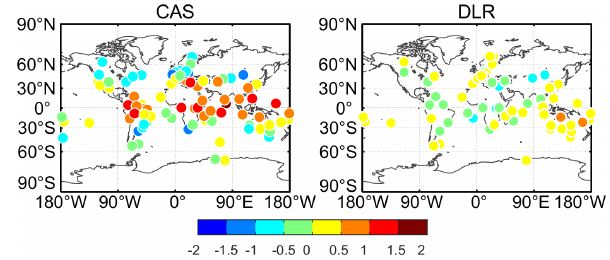
Figure 4. The difference between the estimated BDS receiver DCB with respect to CAS and DLR.